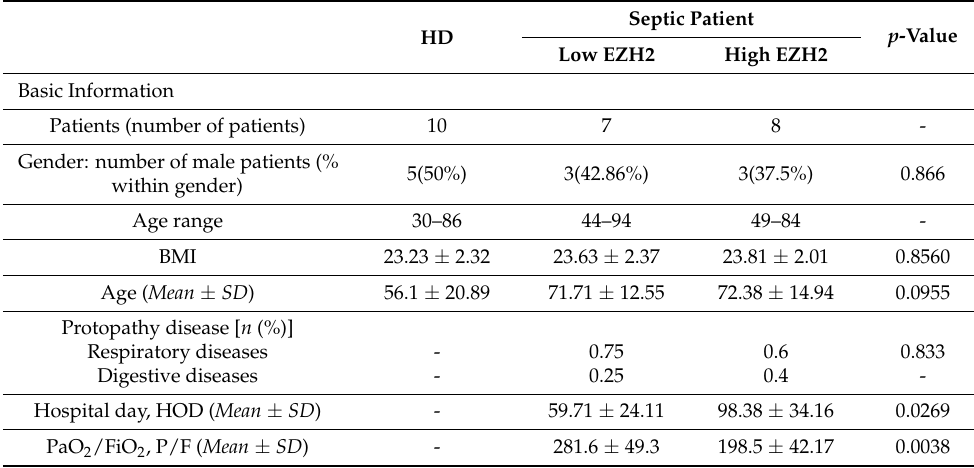
Figure 1. Identification of modules linked to clinical features of SALI and NSCLC. ( A , B ) Cluster dendrogram of co-expressed genes in SALI ( A ) and NSCLC ( B ). ( C , D ) Heat map of module–trait relationships in SALI ( C ) and NSCLC ( D ). ( E ) Venn diagram of the shared genes between the SALI modules and NSCLC modules. ( F ) PPI network of shared genes. ( G ) GSEA of the top 6 enriched pathways in sepsis patients with high EZH2 expression. GSEA, Gene Set Enrichment Analysis. Table 1. The clinical characteristics of the study